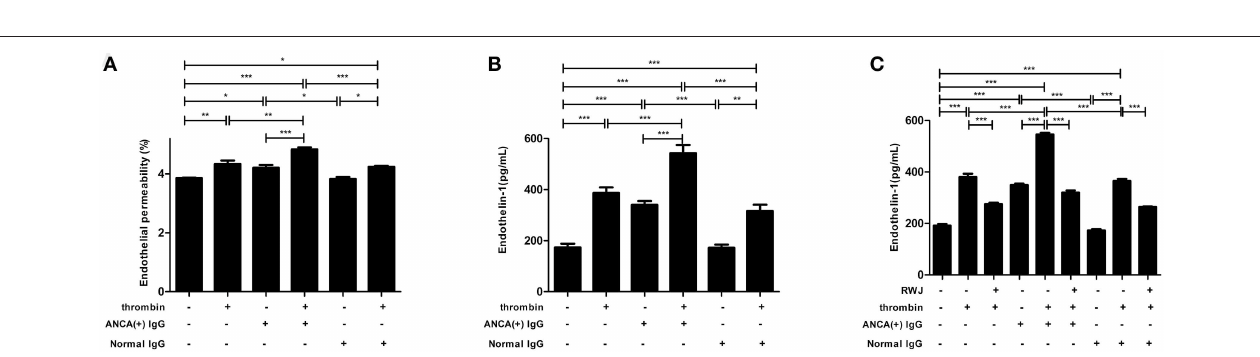
FIGURE 1 | Thrombin could enhance MPO-ANCA-positive IgG-mediated GEnC activation. (A) Thrombin could induce alterations in cellular morphology of GEnCs in the presence of MPO-ANCA-positive IgG. (B) Quantitive assessment of ZO-1 in GEnCs upon stimulation by thrombin and MPO-ANCA-positive IgG. (C) Quantitive assessment of VE-cadherin in GEnCs upon stimulation by thrombin and MPO-ANCA-positive IgG. Bars represent mean ± SD of repeated measurements of five independent experiments or donors. * P < 0.05, ** P < 0.01, *** P < 0.001.